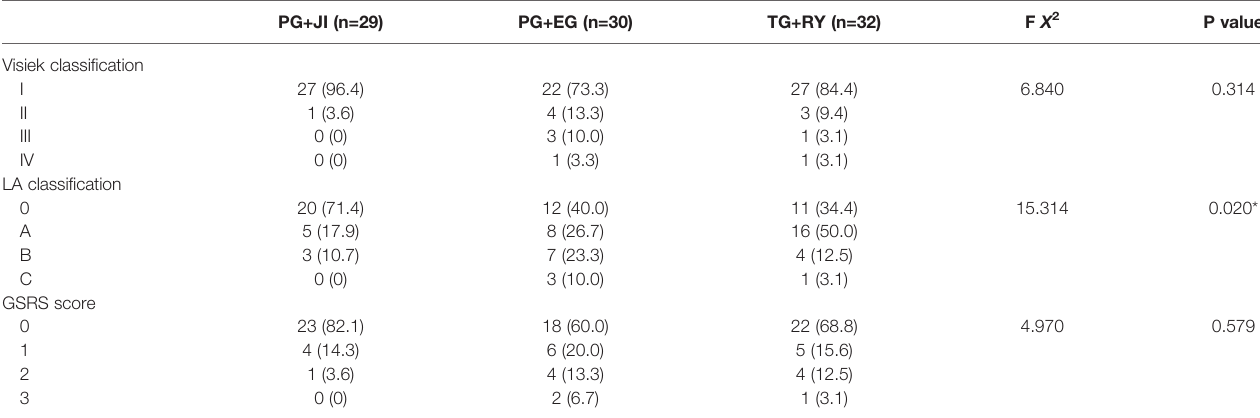
TABLE 4 | Postoperative symptoms.